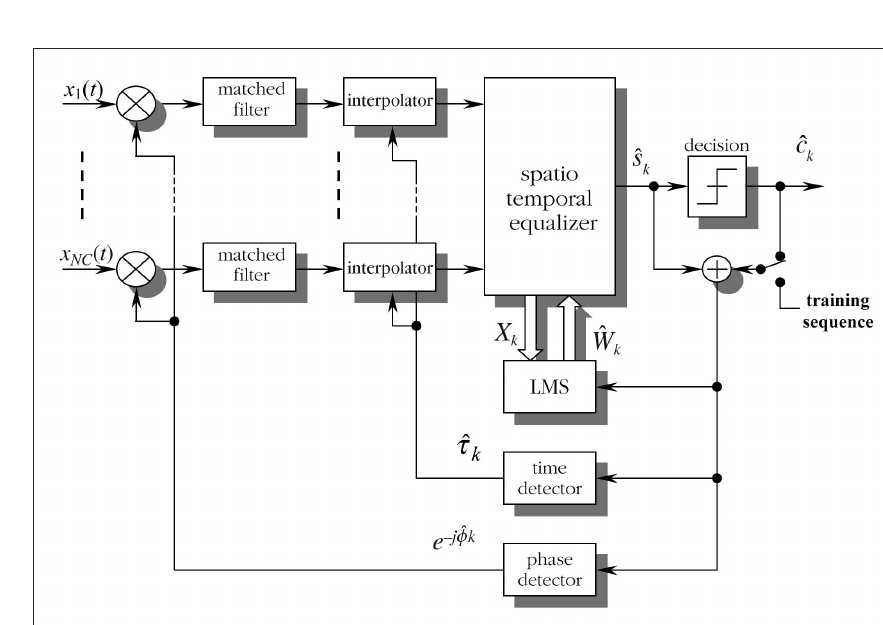
Fig. 13.10. Synopsis of the